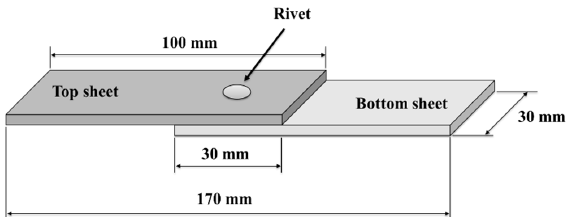
Figure 4. The schematic diagram of the tensile shear test specimen (KS B ISO 14273).